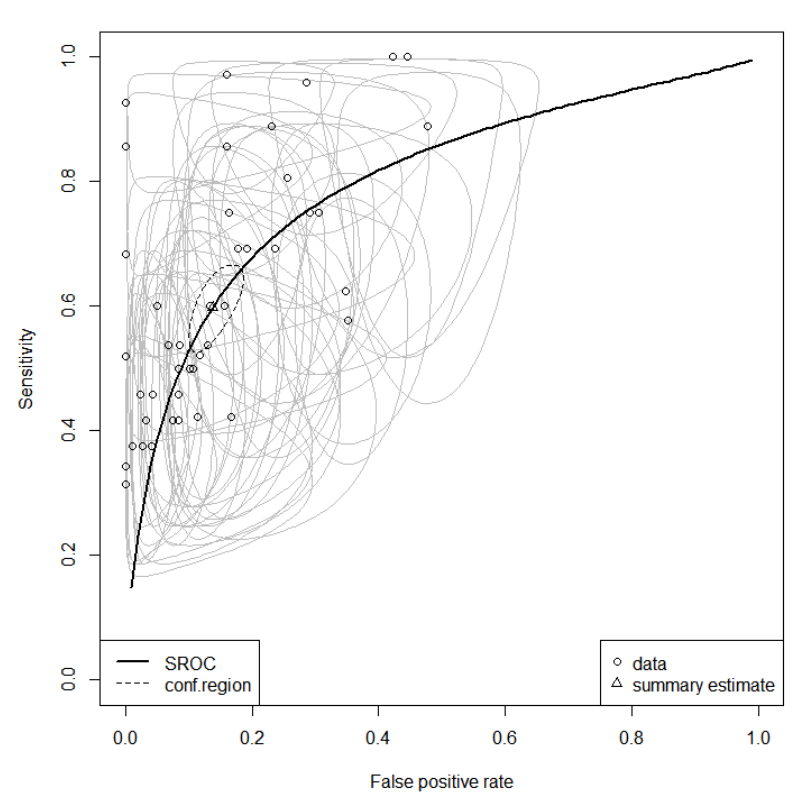
Figure A5. HSROC for all pleural findings and all negative collectives: HSROC curve in black with confidence region (dashed line) of all pleural findings (each shown as a point and 95% confidence region as a gray ellipse) with an AUC of 0.80.